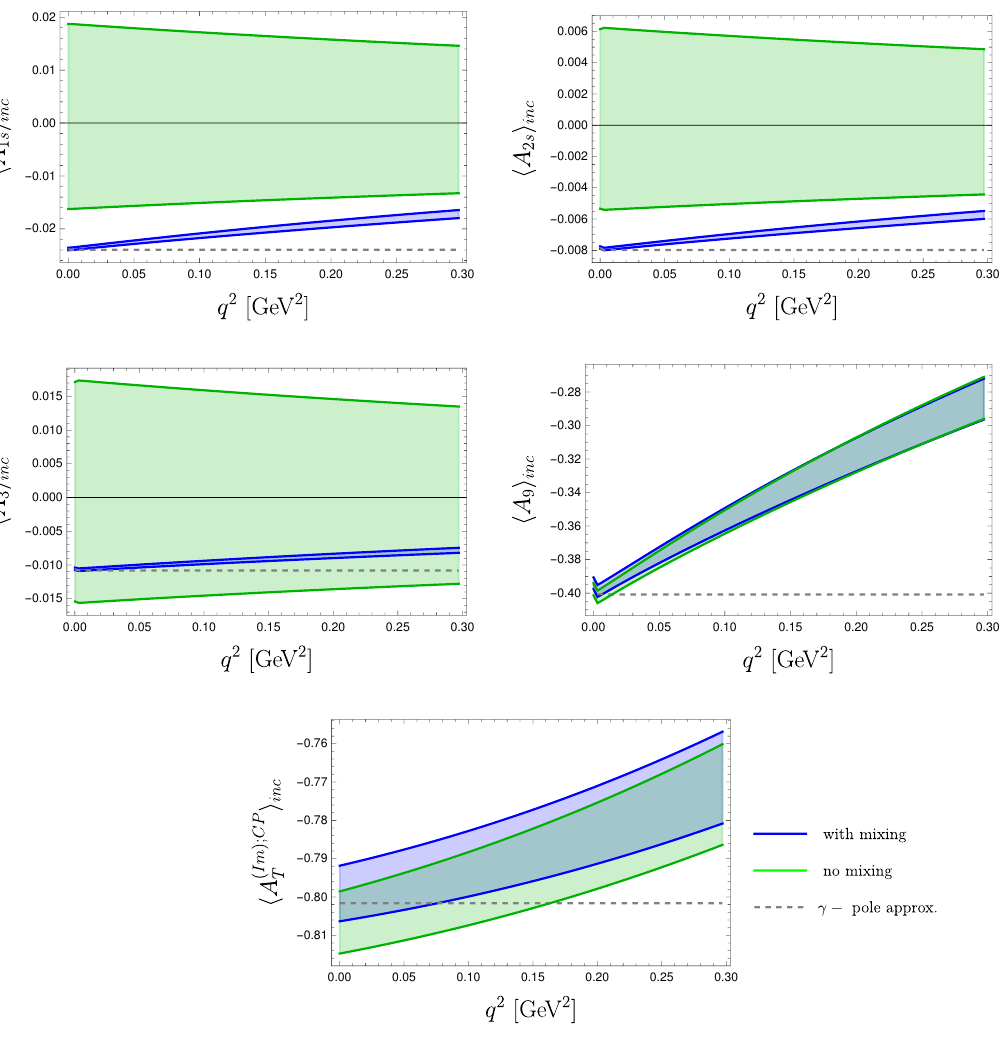
as a function of q 2 in the NP scenario Figure 2 . Predictions for A 1 s , A 2 s , A 3 , A 9 and A ( Im ); CP T defined by ( δ C ) = (0 . 2 i, 0 . 3 i ) . Predictions are shown for the complete expression (blue) and 7 , δ C 7 0 the photon-pole approximation (dashed gray). The full result in the absence of mixing is also shown for illustration